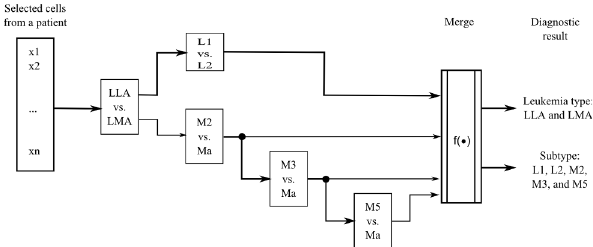
Fig 12. Cascade classification model for the diagnosis of acute